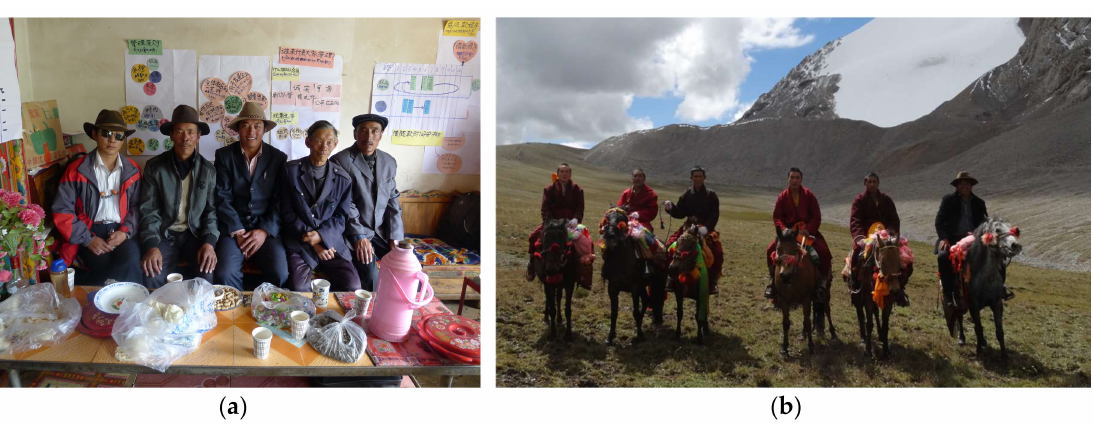
Figure 10. Two community ventures: ( a ) Lari community development revolving fund management group (photo: Du Fachun) and ( b ) tourism development and glacier monitoring by Kegawa Herders Cooperative (photo: Jigme